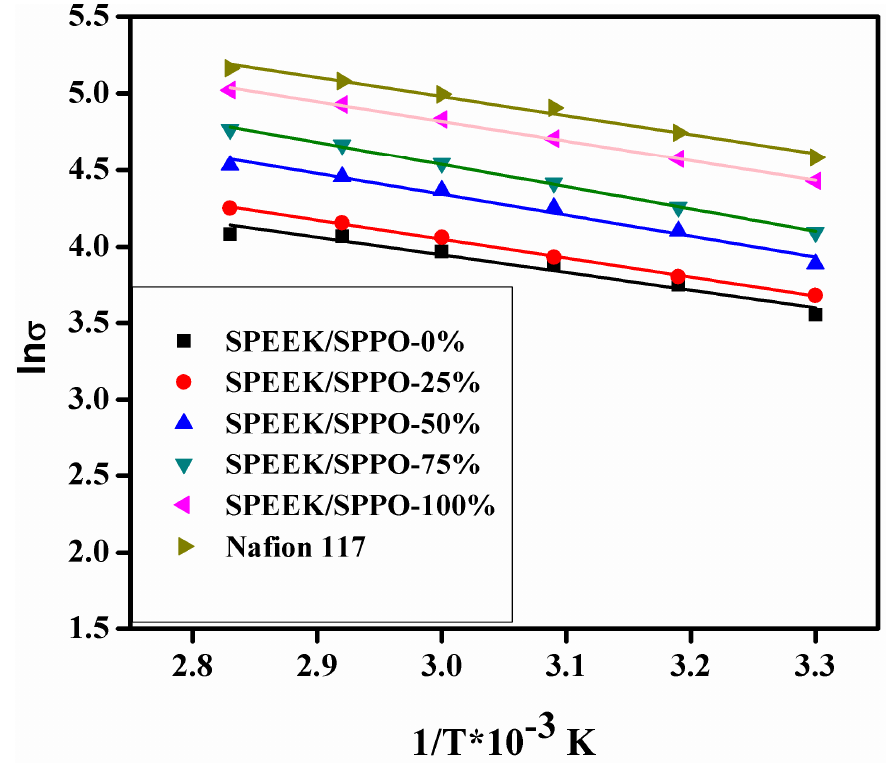
Figure 6. Arrhenius plot of proton conductivity of SPEEK, SPPO and blended SPEEK/SPPO membranes (where 0, 25, 50, 75 and 100% represent the amount of SPPO into the SPEEK/SPPO blended membranes). Table 3. Activation Energy of the fabricated membranes SPEEK/SPPO-0 to SPEEK/SPPO-100 (where 0, 25, 50, 75 and 100% represent the amount of SPPO into the SPEEK/SPPO blended membranes). Sr. No.